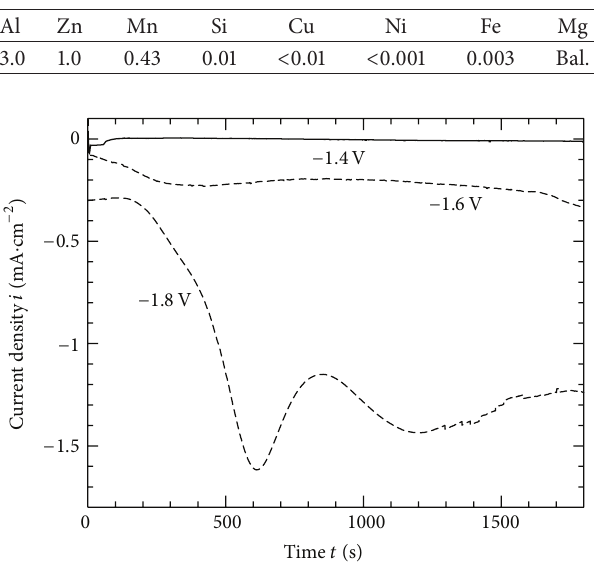
Table 1: Chemical composition (mass%) of AZ31 Mg alloy.